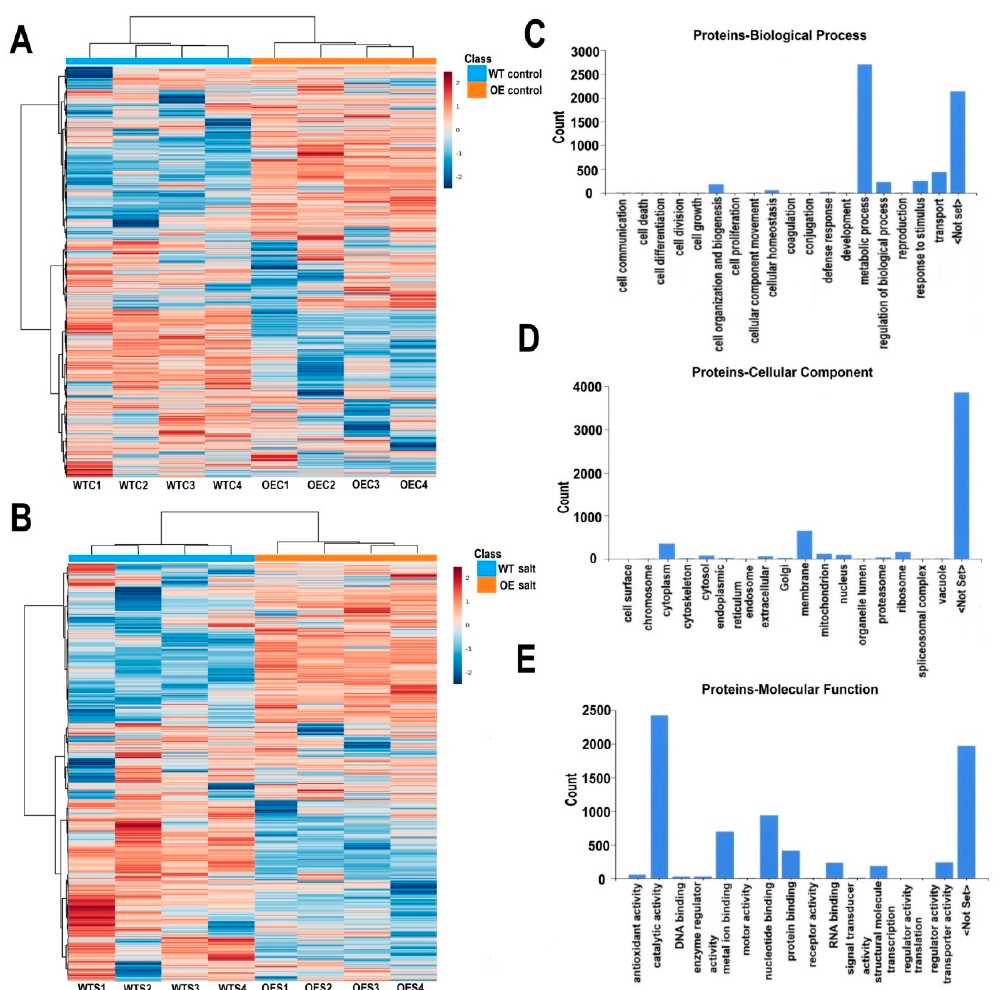
Figure 6. Heatmap of identified proteins under control and high salinity conditions and GO functional categorization of the proteins. ( A ) Identified proteins under control conditions. WTC1–WTC4, four biological replicates of WT under control conditions; OEC1–OEC4, four replicates of OE plants under control conditions. ( B ) Identified proteins under salt stress conditions. WTS1–WTS4, four biological replicates of WT after salt stress treatment; OES1–OES4, four biological replicates of transgenic plants after salt stress treatment. ( C ) Biological process of identified proteins. ( D ) Cellular component of identified proteins. ( E ) Molecular function of identified